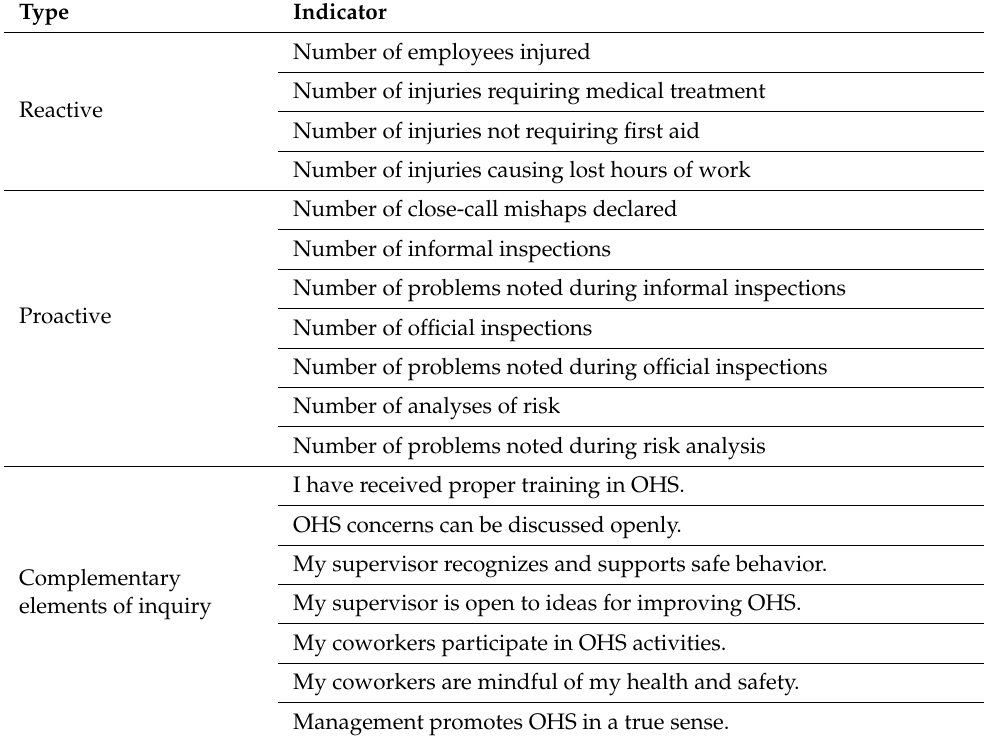
Table 5. Indicators used in the PSI tool